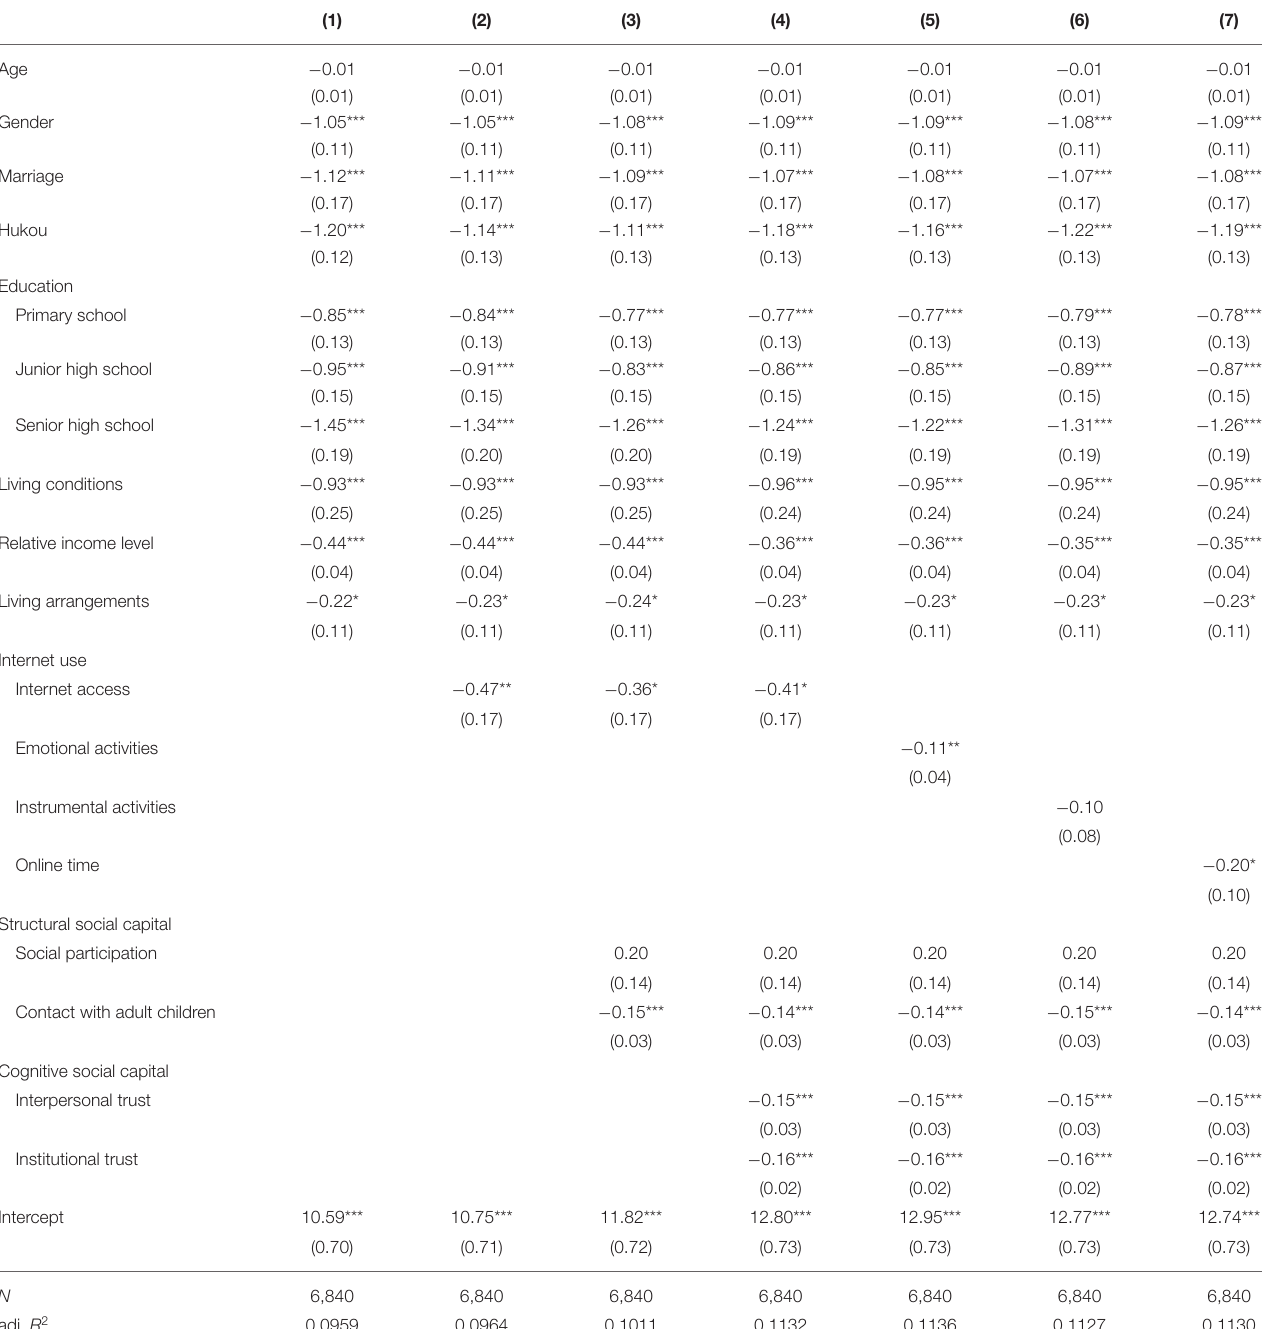
TABLE 2 | Depressive symptoms regressed on Internet use and social